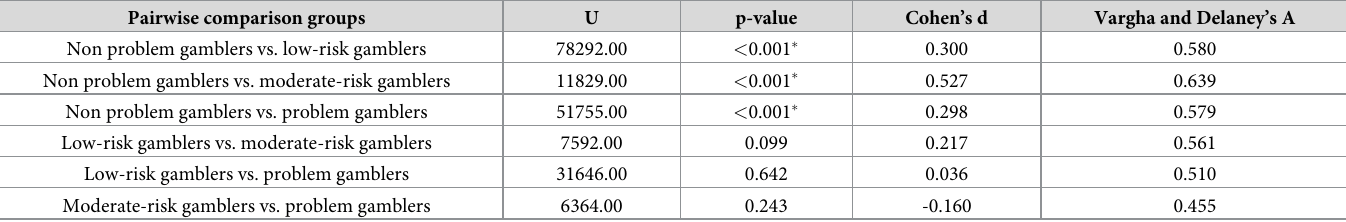
Table 4. Pairwise comparisons of the effects of problem gambling on spending on in-game items other than loot boxes. Pairwise comparison groups U p-value Cohen’s d Vargha and Delaney’s A Non problem gamblers vs. low-risk gamblers